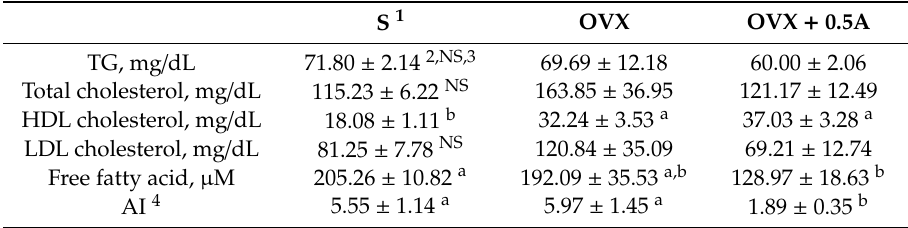
Table 2. E ff ect of A. pilosa on serum lipid